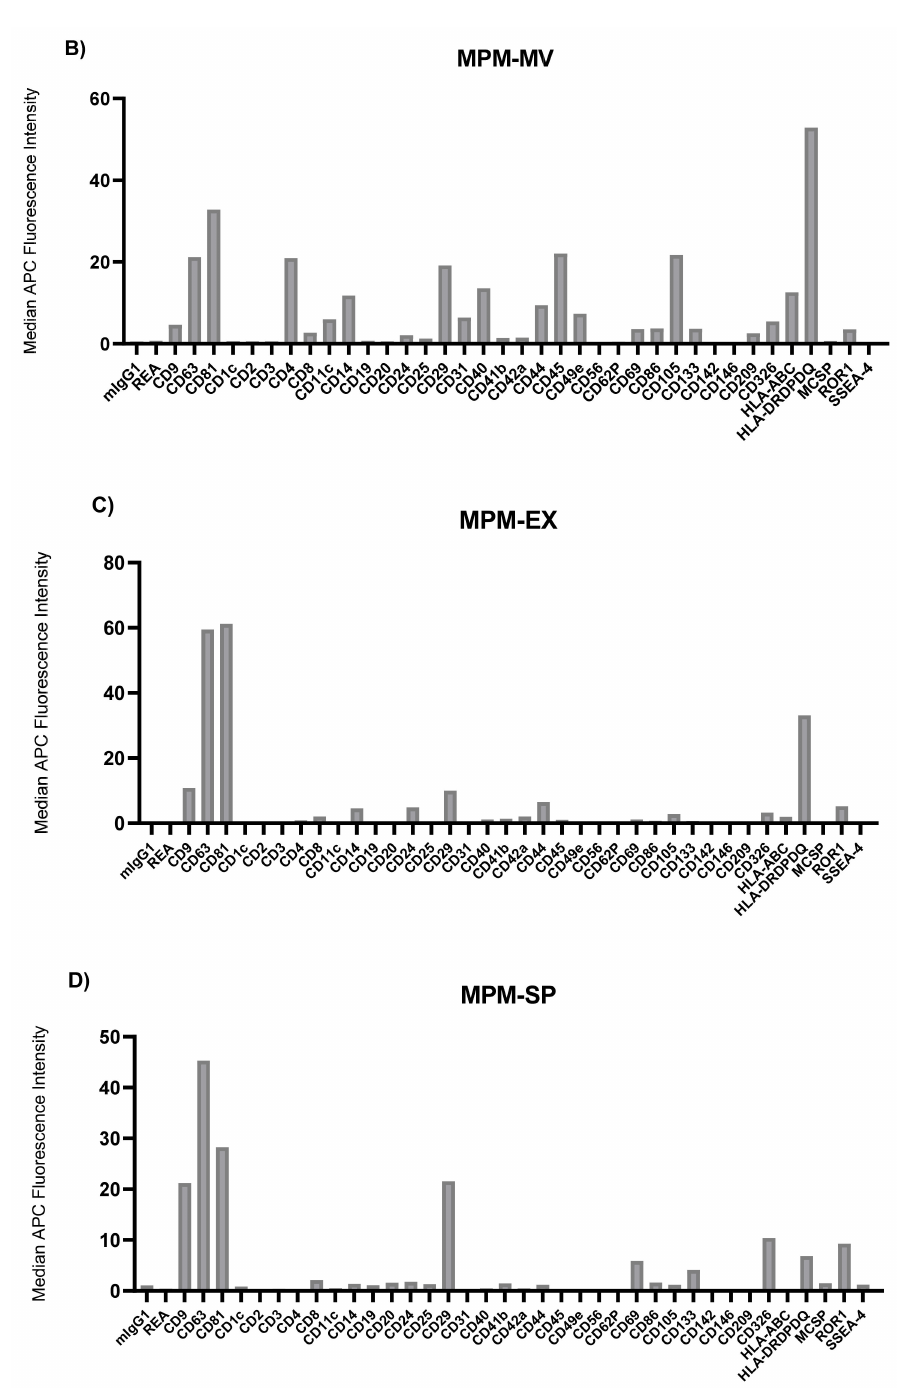
Figure 5. Median fluorescence intensity EV surface protein profiles of malignant pleural mesothe- lioma (MPM) effusion differential centrifugation fractions: apoptotic bodies (AB) ( A ), microvesicles (MV) ( B ), exosomes (EX) ( C ) and soluble protein in supernatant (SP) ( D ). mIgG1 and REA indi- cate isotype control and represent negative markers. Each bar corresponds to one surface epitope measurement, as indicated on the x